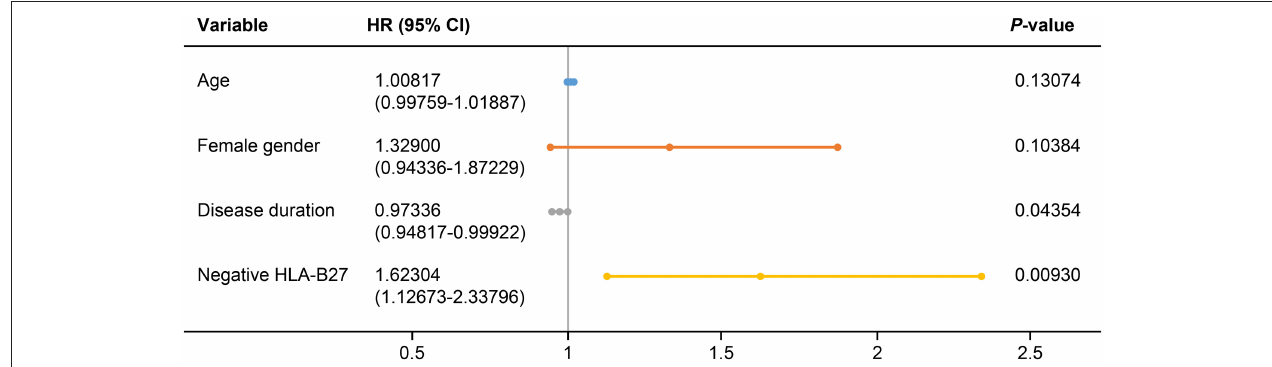
FIGURE 3 | Forest plot based on the results of multivariate analyses of the factors associated with discontinuation of TNFis. HLA, human leukocyte antigen; HR, hazard ratio; CI, confidence interval.